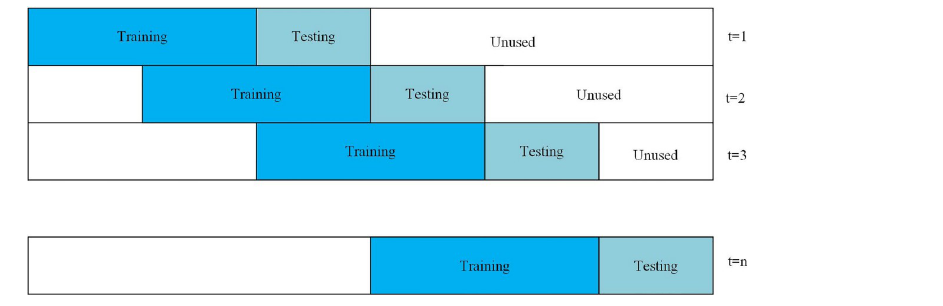
Fig 1. The schematic diagram of walk-forward